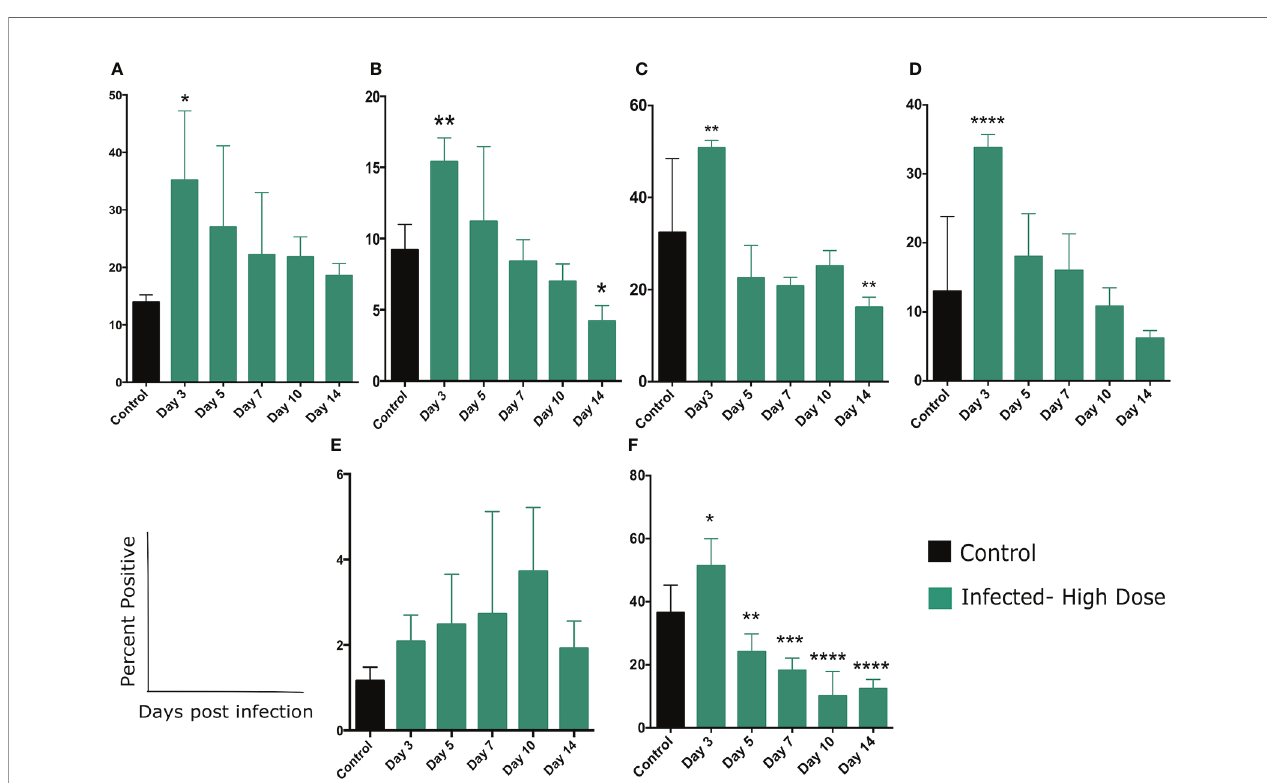
FIGURE 5 | Changes in cellular metabolism in Ly6C and Ly6G-expressing cells. (A) Percent of splenocytes expressing Ly6C following Lm infection and (B) Percent of Ly6C + cells expressing Glut1 over the course of the infection. (C) Percent of Ly6C int or (D) Ly6C hi cells expressing Glut1. (E) Percent of splenocytes expressing Ly6G following Lm infection and (F) Percent of Ly6G + cells expressing Glut1 over the course of the infection. Signi fi cance was assessed using one-way ANOVA followed by a Dunnett Test for multiple comparison. Data are represented as mean ± SD. High Dose (n = 5) - Control (n = 3). *p < 0.05, **p < 0.01, ***p < 0.005, ****p <